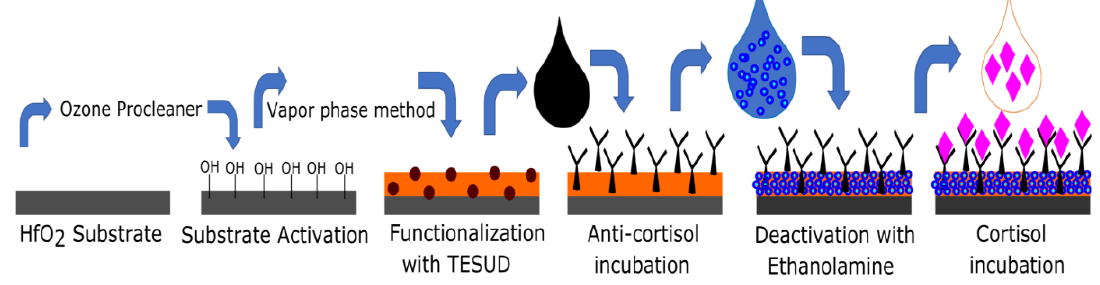
Figure 3. Functionalization procedure of the HfO 2 surface.